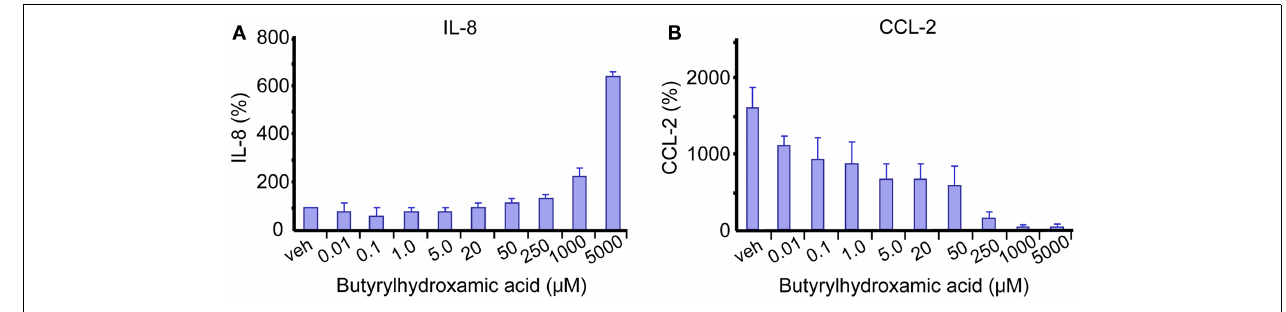
Figure 1 of Dietary inhibitors of histone